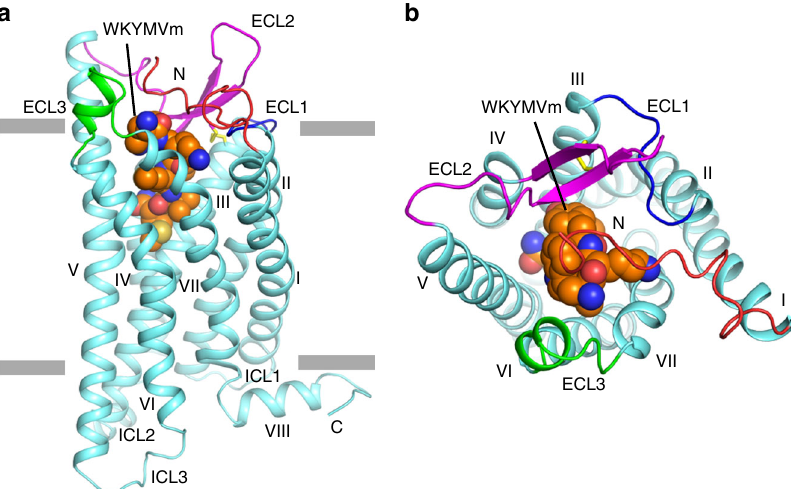
Fig. 1 Overall structure of the FPR2-WKYMVm complex. a Side view of the FPR2-WKYMVm structure. The receptor is shown in cartoon representation and colored cyan. The N terminus and the extracellular loops, ECL1, ECL2 and ECL3, of the receptor are colored red, blue, magenta, and green, respectively. The peptide WKYMVm is shown as spheres with carbons in orange. The disul fi de bond is shown as yellow sticks. The membrane boundaries are indicated by gray blocks. b Extracellular view of the FPR2-WKYMVm